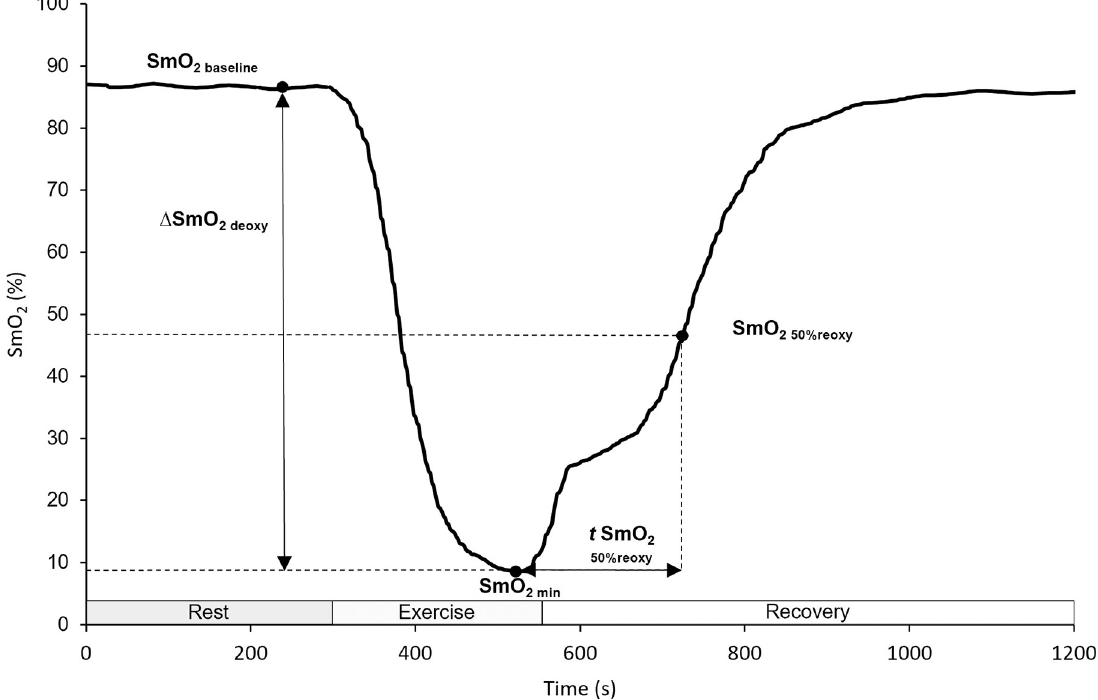
Fig 2. Representative example of SmO 2 -derived parameters, based on information from the author. SmO 2 baseline , baseline of muscle oxygen saturation; Δ SmO 2 deoxy , amplitude of muscle oxygen deoxygenation; SmO 2 min , minimum of muscle oxygen saturation; t SmO2 50%reoxy , time to recover 50% of muscle oxygen saturation; SmO 2 50%reoxy , 50% of muscle oxygen reoxygenation.